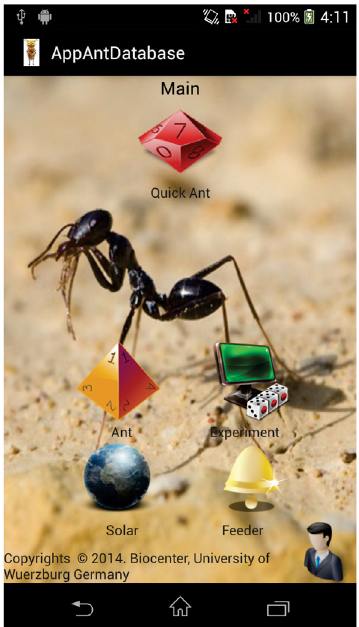
Figure 13. App Ant Database’s smart phone graphical user interface. Scientifc software solution towards the experiment data management during experimentation on desert ants. It offers user friendly graphical interfaces for the experimental data entrance, manipulation, management and sharing (http://www.